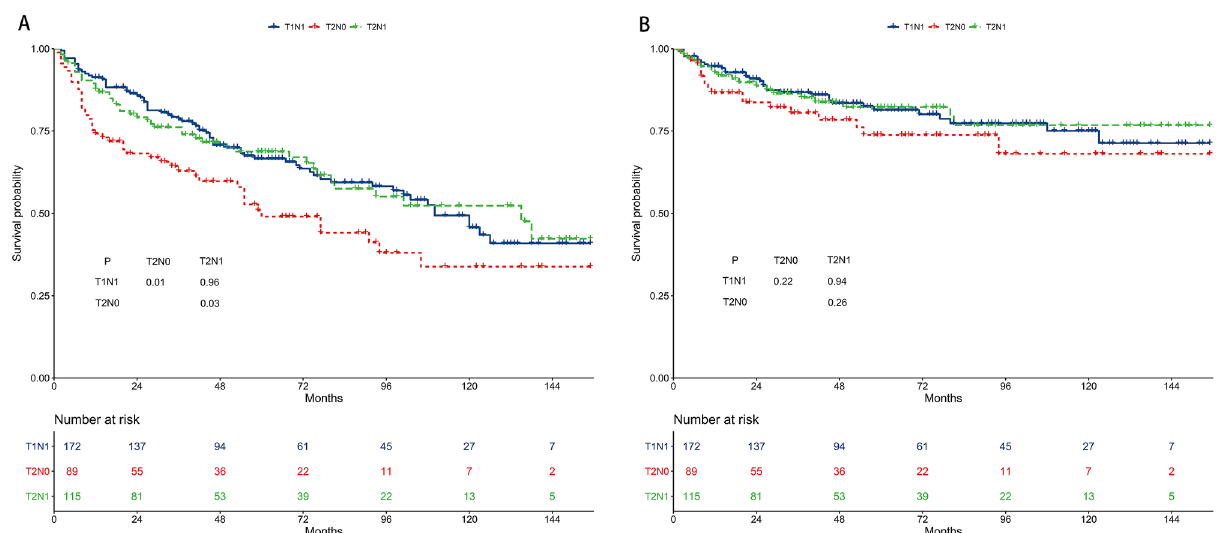
Figure 7. Survival outcomes of the T1N1, T2N0, and T2N1 subgroups in the WHO I group. ( A ) Overall survival. ( B ) Cancer-specific